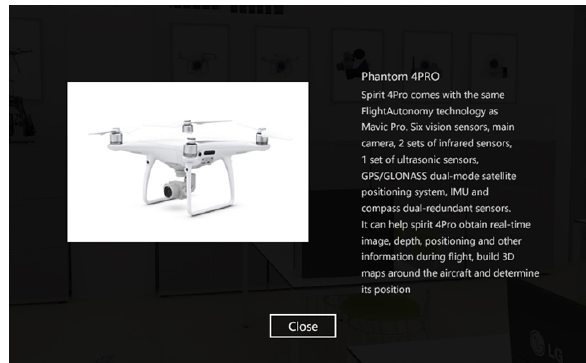
Figure 3. Phantom 4 PRO knowledge show